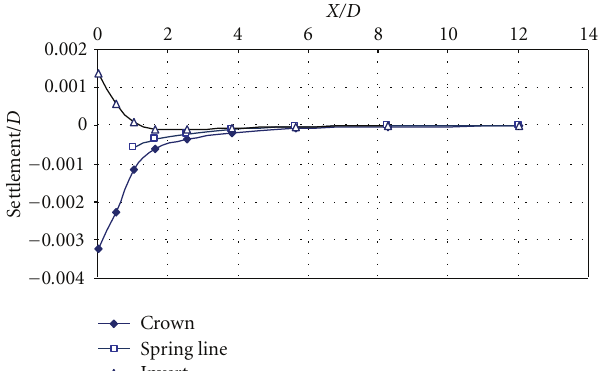
Figure 8: Vertical displacement at the end of excavation of the tunnel using MCC model.